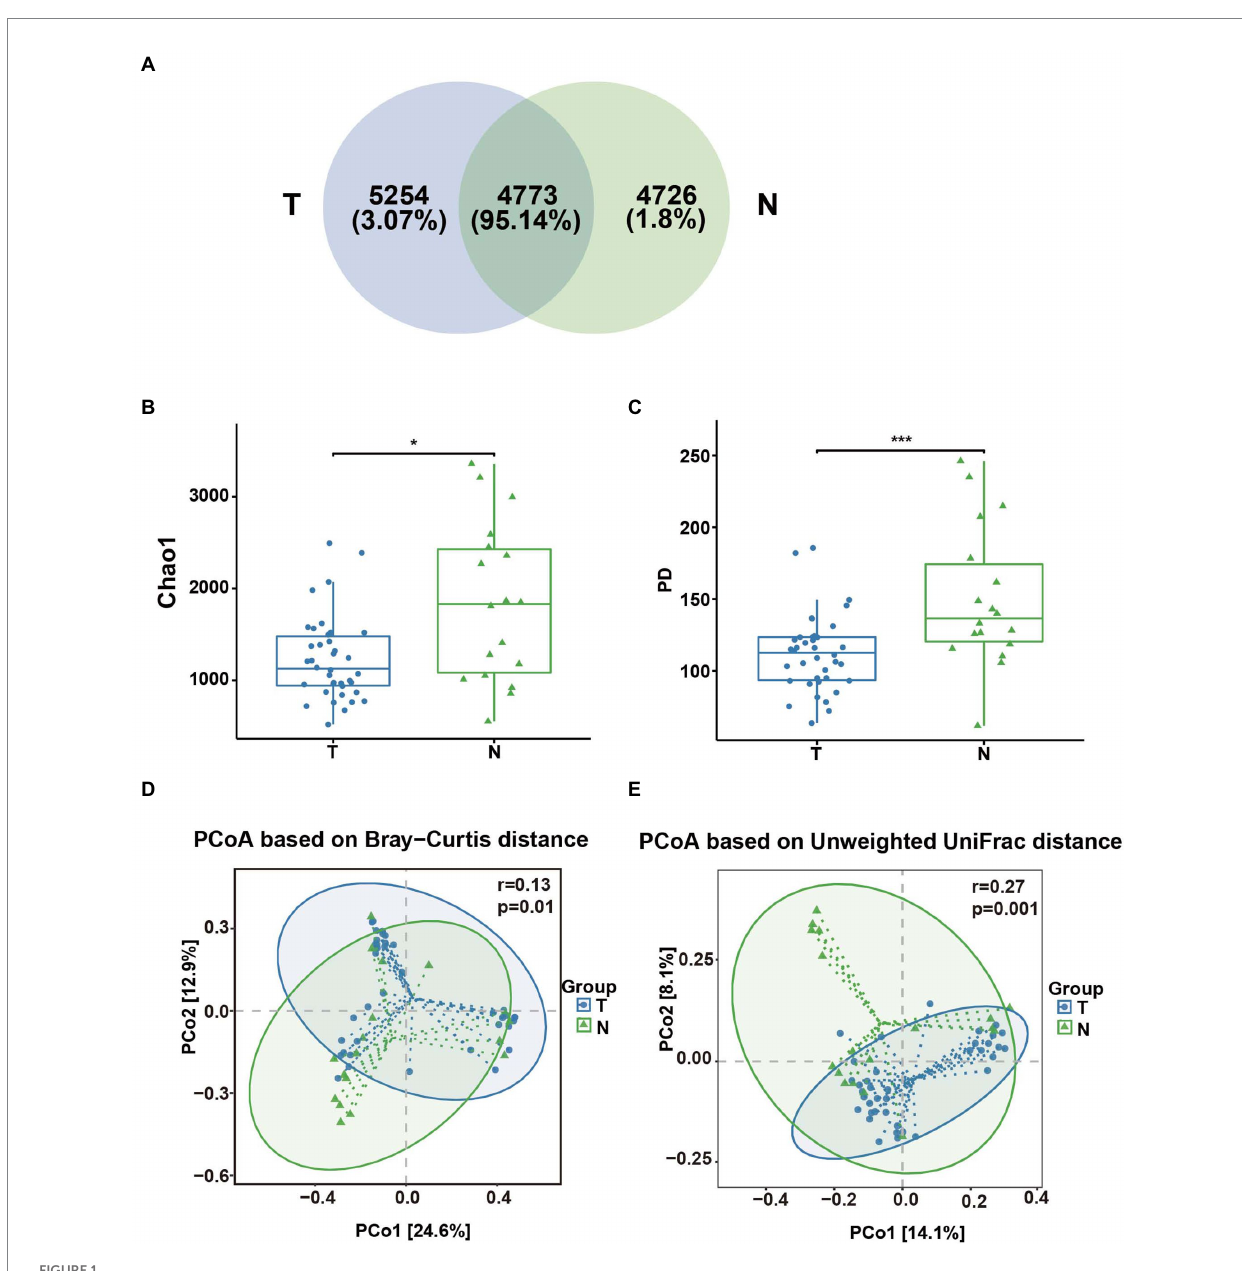
FIGURE 1 Analysis of the diversity of the vaginal microbial composition in the embryo-arrest and normal pregnancy groups. (A) Venn diagram of the numbers of operational taxonomic units (OTUs) identified in the two groups. (B) α -diversity of chao1. (C) α -diversity of the PD whole tree. (D) PCoA plot of the Bray–Curtis distance between the two groups. (E) PCoA plot of unweighted Uni-Frac distance between the two groups. T, embryo-arrest group; N, normal pregnancy group. Significance was tested with the Wilcoxon rank-sum test. * p < 0.05; *** p <